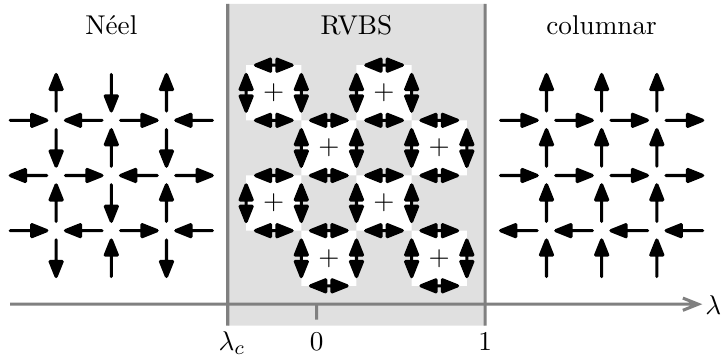
Figure 2: Zero temperature phase diagram as a function of the Rokhsar-Kivelson coupling λ , depicted with cartoon lattice configurations. A quantum phase transition = 1 separate a resonating valence bond solid (RVBS) at λ and the RK-point λ c RK phase (shaded) from Néel- and columnar